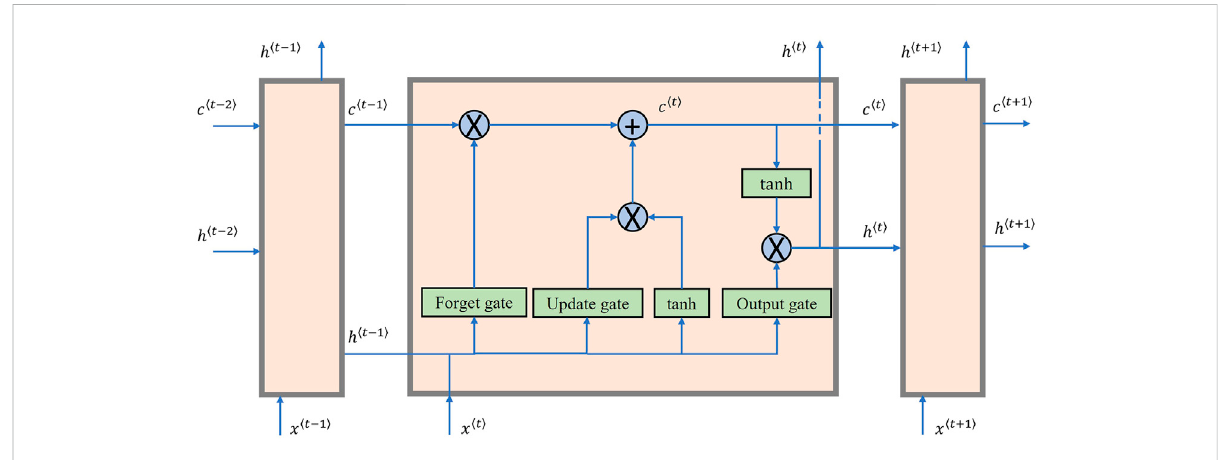
FIGURE 2 Unfolded LSTM layer showing internal operation for time series.